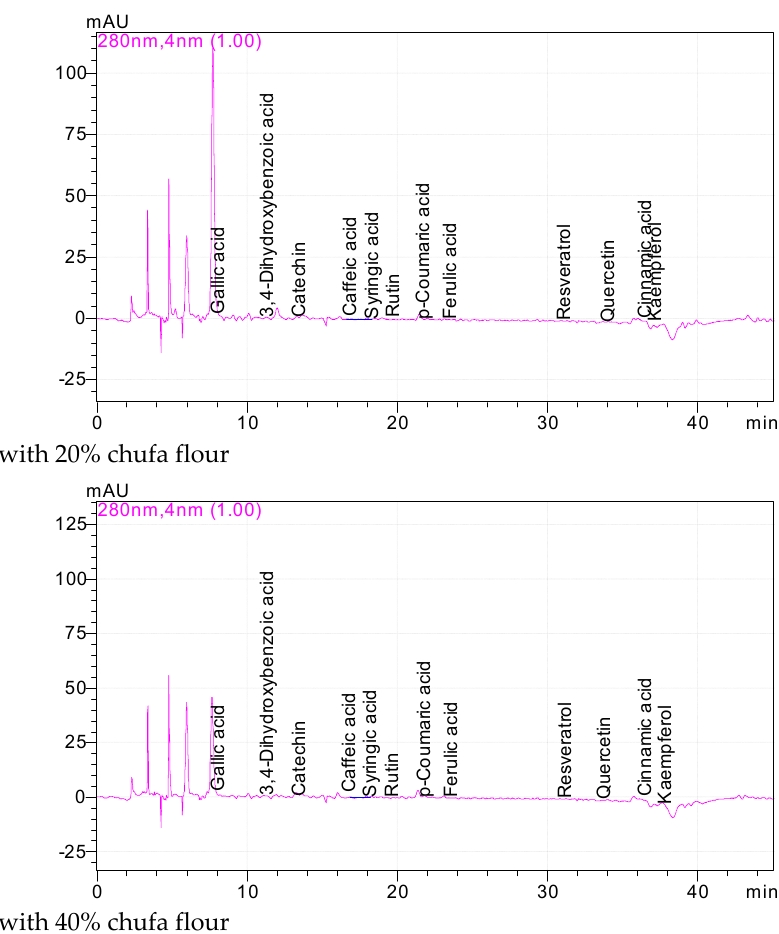
Figure 2. Phenolic chromatograms of the breads enriched with chufa flour at different concentrations. 3.3. The Fatty Acid Composition of the Oils of the Wheat Breads Enriched with Chufa Tuber The fatty acid profiles and their quantitative values of the wheat breads enriched with chufa tuber powders in three different concentrations are presented in Table 3. Palmitic and stearic acid amounts of the oils of the breads enriched with chufa tuber powders changed between 14.56% (with 10% chufa) and 15.00% (with 40% chufa) to 2.35 (with 40% chufa) and 3.76% (control), respectively. In addition, oleic and linoleic acid amounts of the oils of the bread samples enriched with chufa tuber powders were identified between 61.88 (control) and 66.64% (with 40% chufa) to 14.84 (with 40% chufa) and 17.55% (control), respectively (Figure 3). Other fatty acids (myristic, arachidic, linolenic, and behenic acids) detected in bread oils were detected at minor levels (<0.65%). The stearic and linoleic acid contents of the oils extracted from bread enriched with chufa tuber powder have changed together with the increase in chufa concentrations. In addition, an important increase in the oleic acid content of the bread was observed depending on the chufa tuber concentrations. The highest palmitic (15.00%) and oleic acid (66.64%) concentrations were detected in the oil of the bread enriched with chufa power at a concentration of 40%. Statistically significant differences were observed among fatty acid contents of the oils extracted from bread samples with chufa flour compared with the control ( p < 0.05). Yoon [47] identified 15.2–16.0% palmitic, 2.0–2.2% steraic, 64.4–66.1% oleic, 14.8–15.9% linoleic, 0.4–0.5% linolenic, and 0.5–0.6% arachidic acids in chufa oils extracted by the different solvents (diethyl ether, n-Hexane, and chloroform/methanol). The results were similar compared with the literature